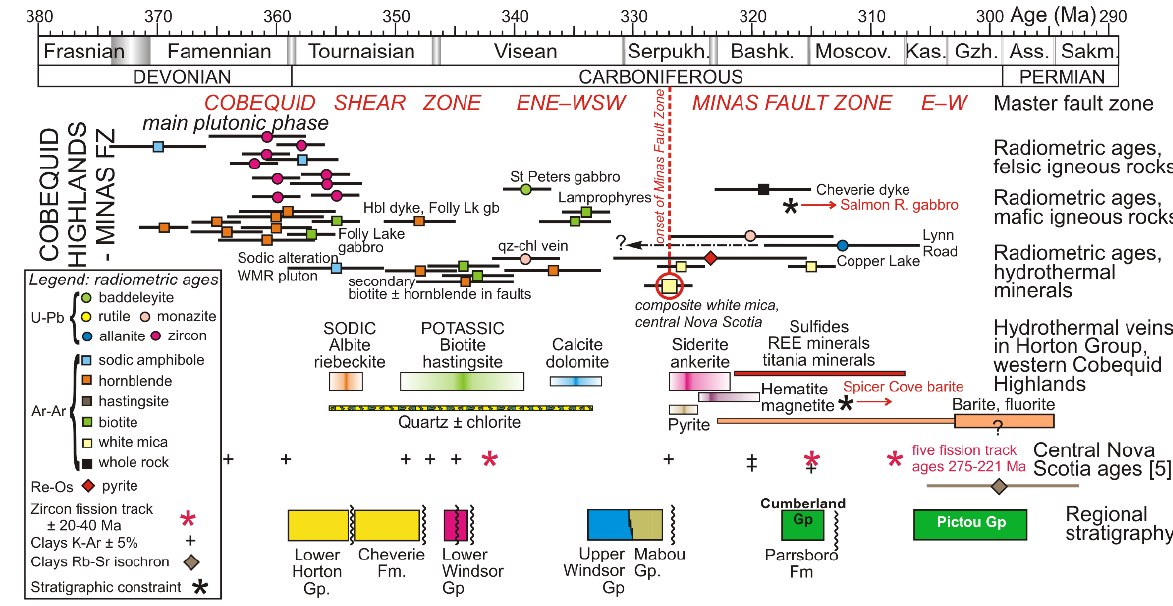
Figure 12. Timeline for mineral veins in Carboniferous rocks of the Cobequid Highlands.